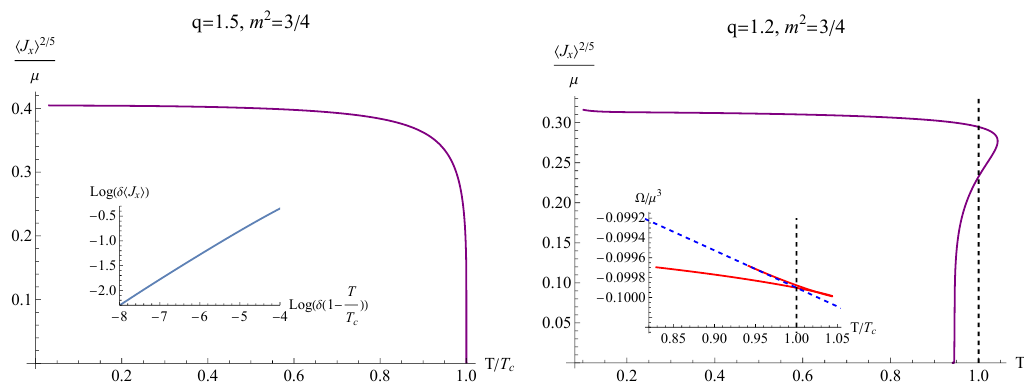
Figure 1 . Left plot: the second-order phase transition occurs as the temperature falls below the critical value. The inset plot illustrates the scaling behavior of the condensate h J x i . Right plot: the first-order phase transition occurs when the temperature falls below the critical temperature, which is represented by the black dashed line. The inset plot illustrates the free energy density Ω versus the temperature T/T c , revealing that the superconducting phase is thermodynamically favored.